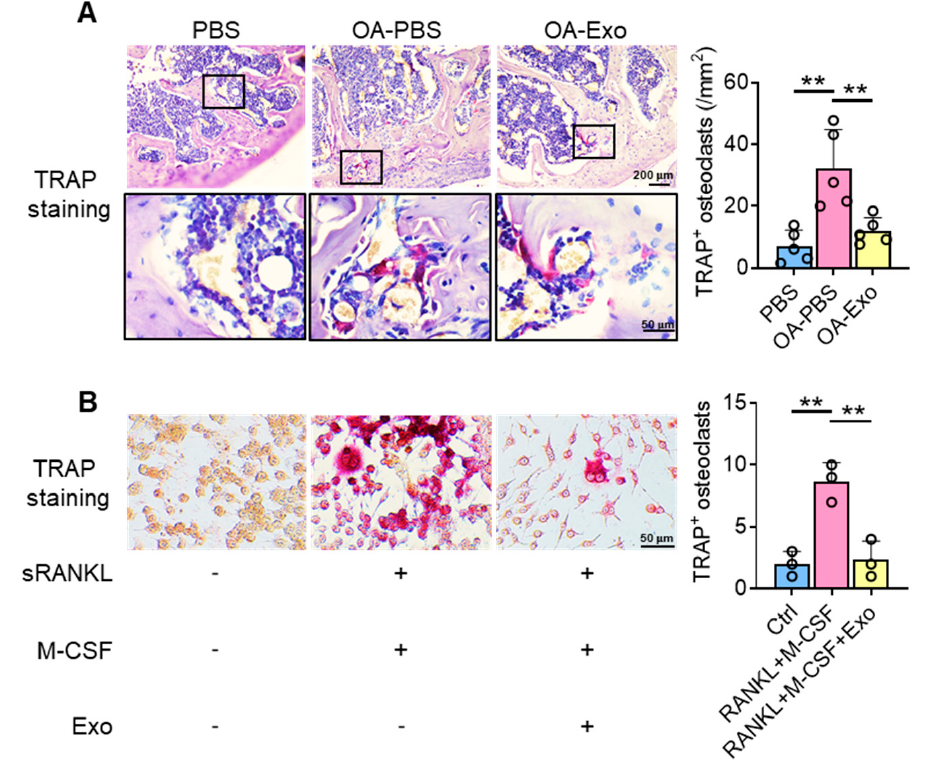
Figure 4. DPSC-Exos inhibited osteoclast activation in the subchondral bone. ( A ) Representative images of osteoclasts in the subchondral bone by TRAP staining. Data are presented by mean ± SD. ** p < 0.01; n = 5. ( B ) Representative images of RAW 264.7 cells by TRAP staining after osteoclast induction. The data were collected from three independent samples and are presented by mean ± SD. ** p < 0.01.